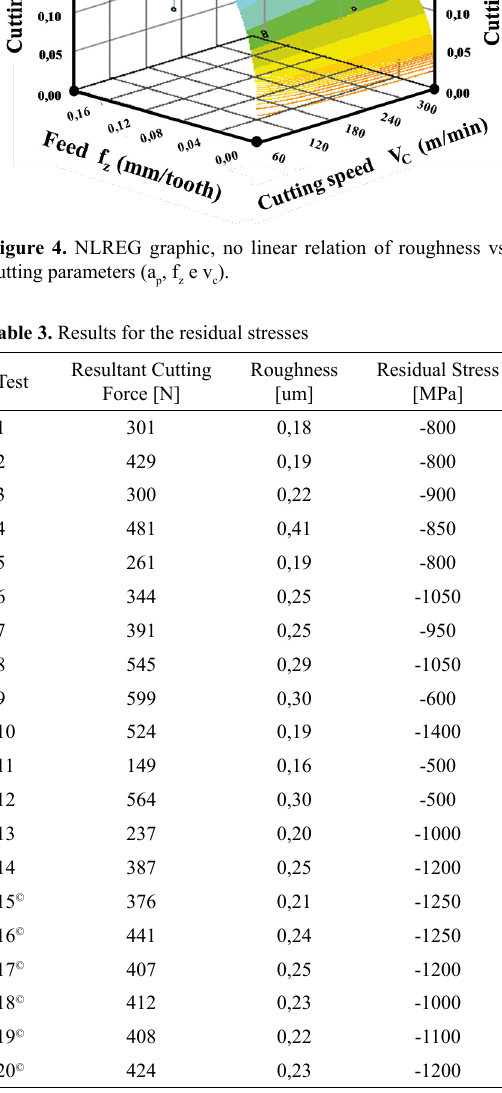
Figure 6: Countor chart (f a = 0,15 p